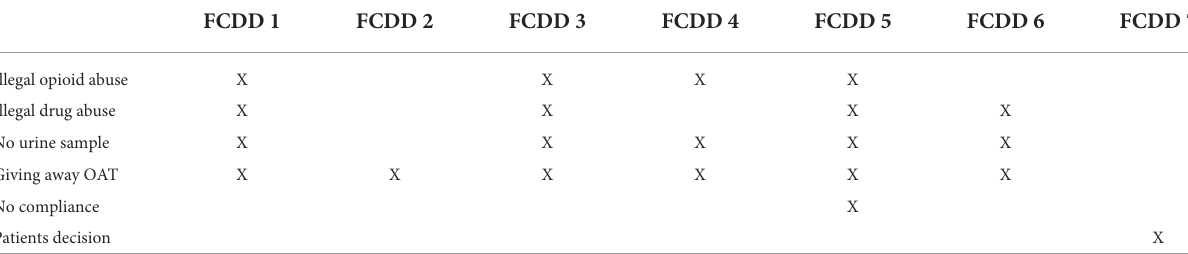
TABLE 3 Clinical practice for ending OAT in the seven Forensic Clinics for Dependency Diseases offering